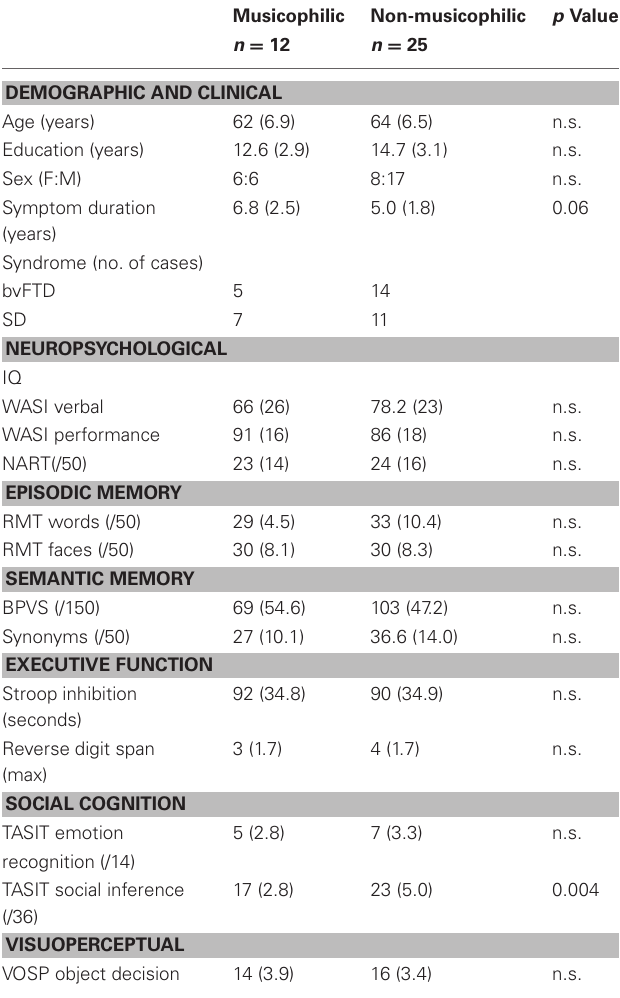
Table 1 | Summary of patient demographic, clinical, and neuropsychological